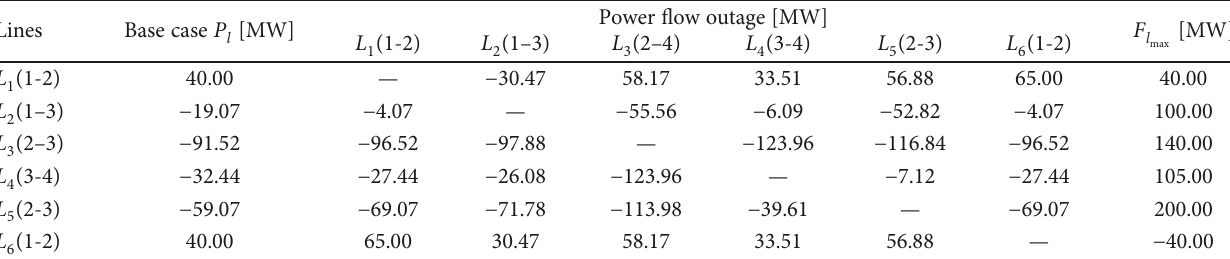
Table 14: Power fl ow after line outage using distribution factors [75].